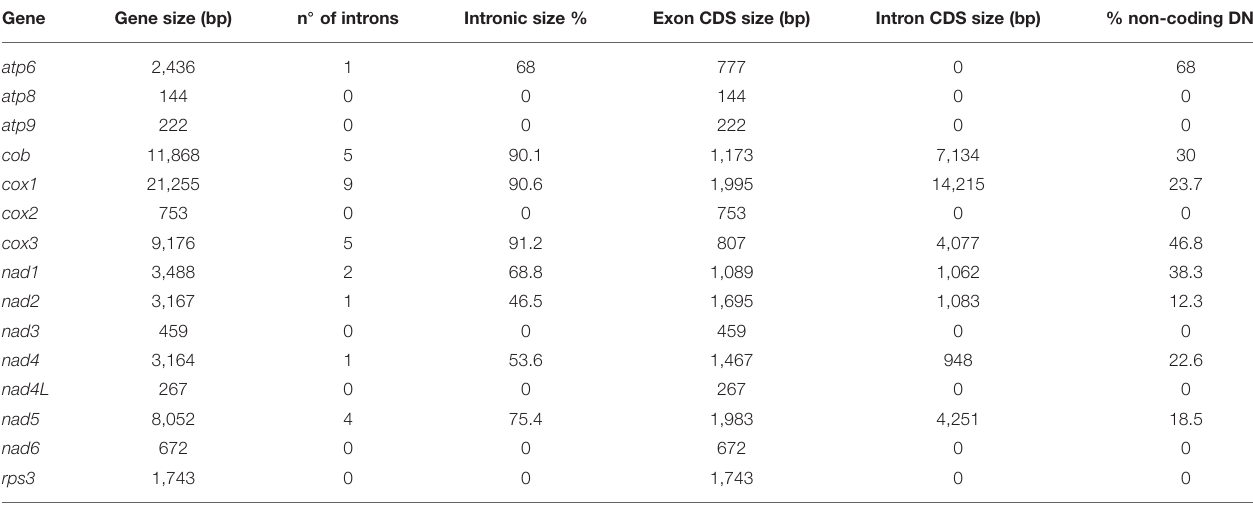
Intron CDS size is the length of sequences encoding ORFs.